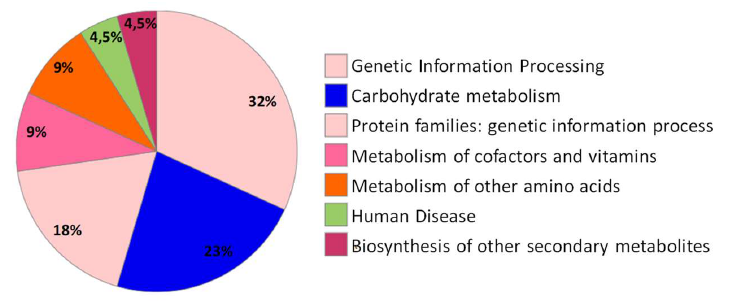
Figure 4. The protein sequences of citrus-specific genes were functionally annotated with metabolic information from the Kyoto Encyclopedia of Genes and Genomes (KEGG) pathway database using KEGG Orthology And Links Annotation (BlastKOALA) program.